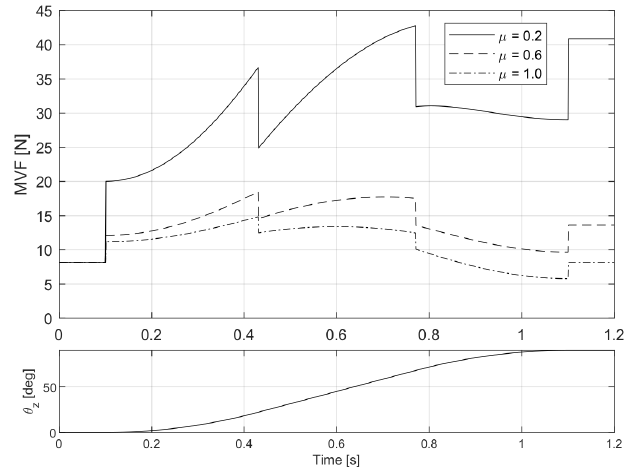
Figure 6. ( Upper plot ): Minimum vacuum force required during the rotation of a box as a function of time. Results are presented for different friction coefficients. ( Bottom plot ): Inclination angle θ z . Note that the two plots shares the x